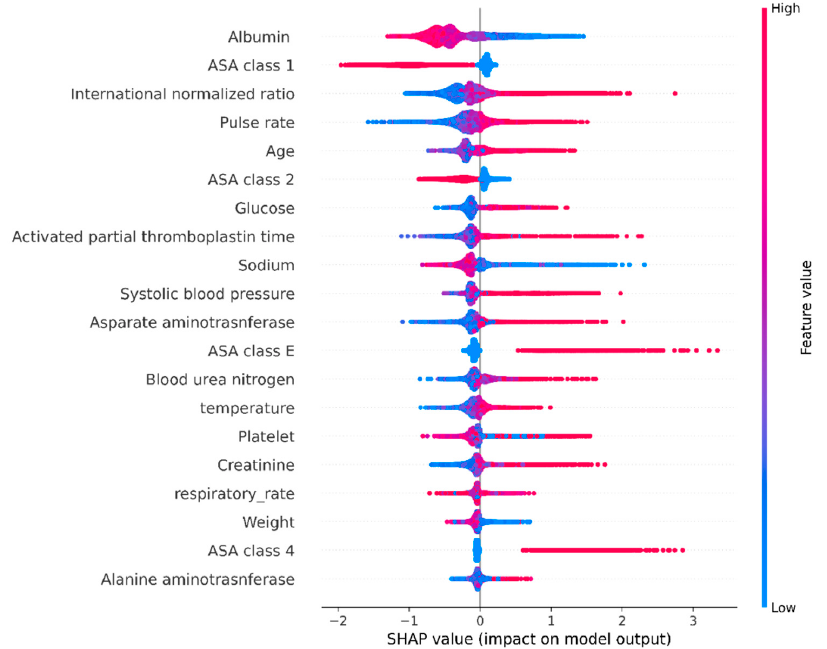
Figure 5. SHapley Additive exPlanations (SHAP) beeswarm plot shows a summary of how the top features in a dataset impact the model’s output. A red color means a high feature value. The blue color means a low feature value. Each point represents an individual person. The horizontal position of each point shows the impact of the feature on the model’s prediction. For example, in the case of ASA (American Society of Anesthesiologists) class 1, a high feature value (the red color) influences the model to predict less death. Conversely, in the case of age, the high feature value affects the model to predict more